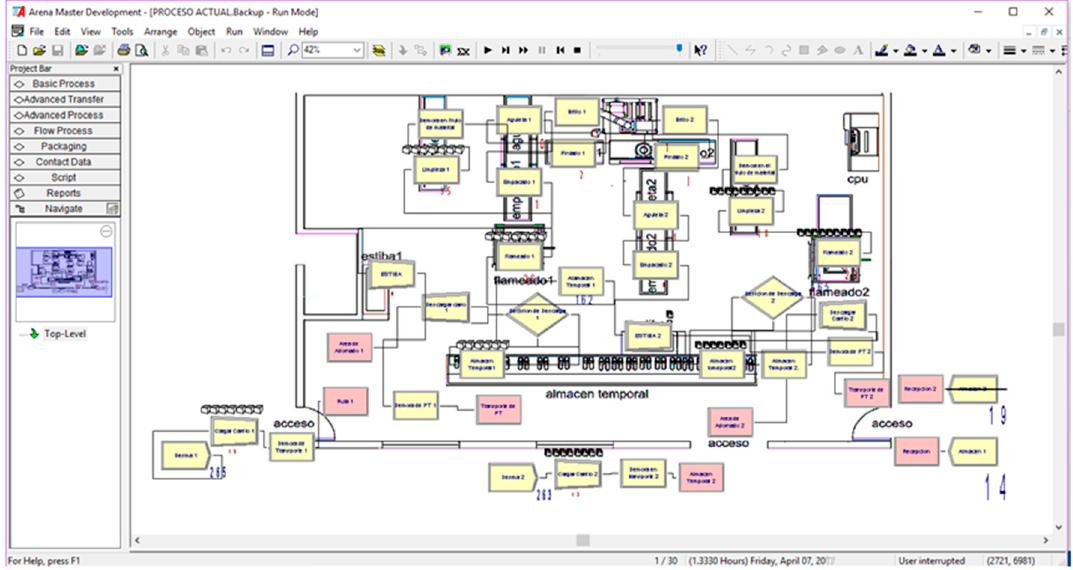
Figure A1 . Simulation in process. Current configuration. Figure A1. Simulation in process. Current